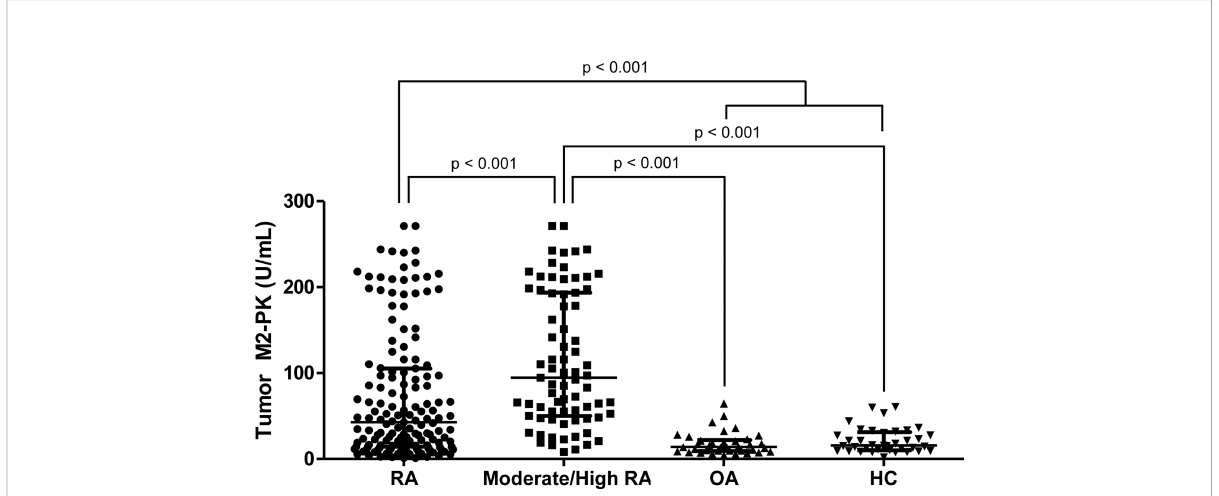
FIGURE 5 Comparison of tumour M2-PK levels in patients with RA, OA, and controls. Tumour M2-PK levels were compared between patients with RA with moderate/high disease activity, OA, and controls. Differences between the two groups were compared using the Mann – Whitney U test. The error bars indicate median values and interquartile range. Tumour M2-PK, dimeric form of pyruvate kinase M2; RA, rheumatoid arthritis; OA, osteoarthritis; HC, healthy controls.